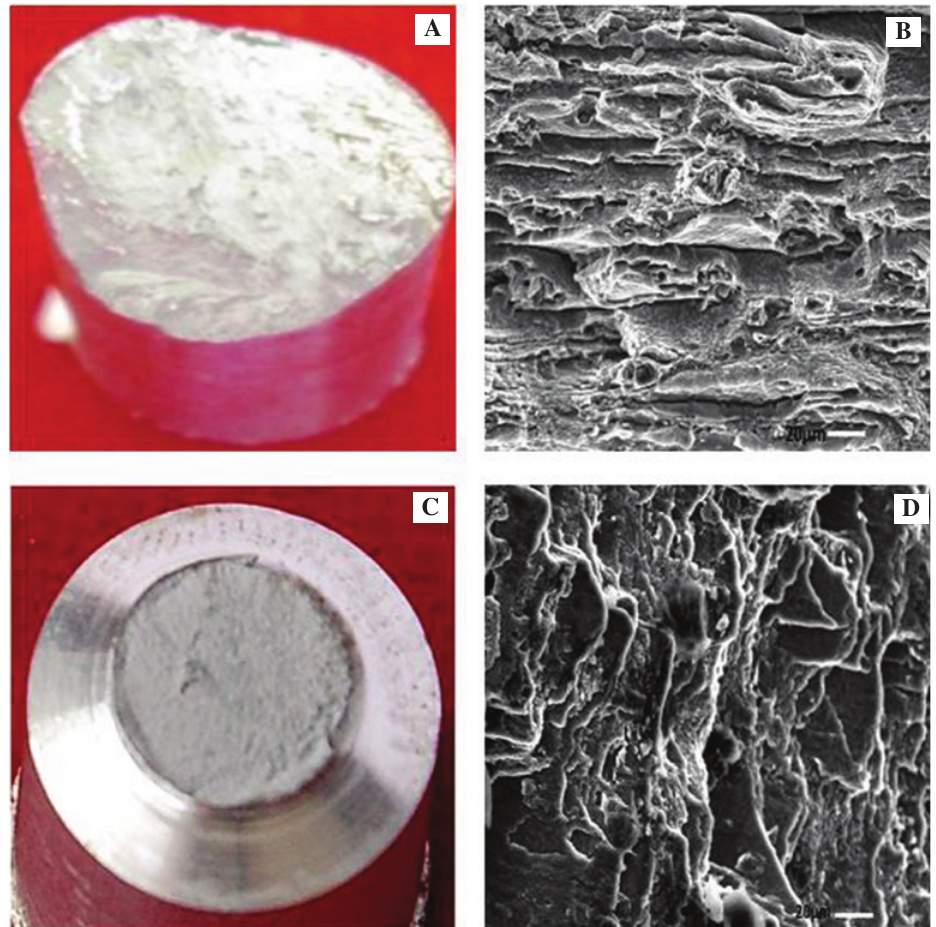
Figure 6: Fracture surfaces of tensile tested AA7075 in air environment. (A, B) Fractured surface of unnotched specimen. (C, D) Fractured surface of notched